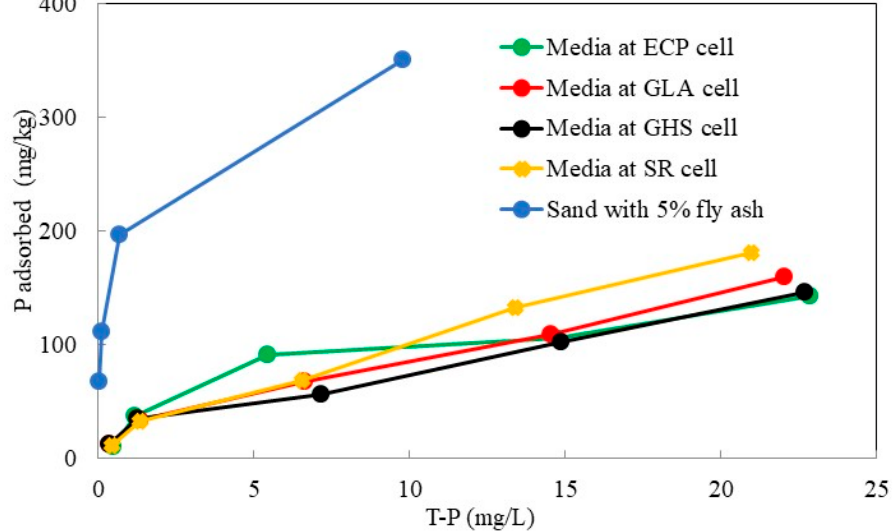
Figure 13. Phosphorus adsorption isotherms in aged BRC media and unweathered fly